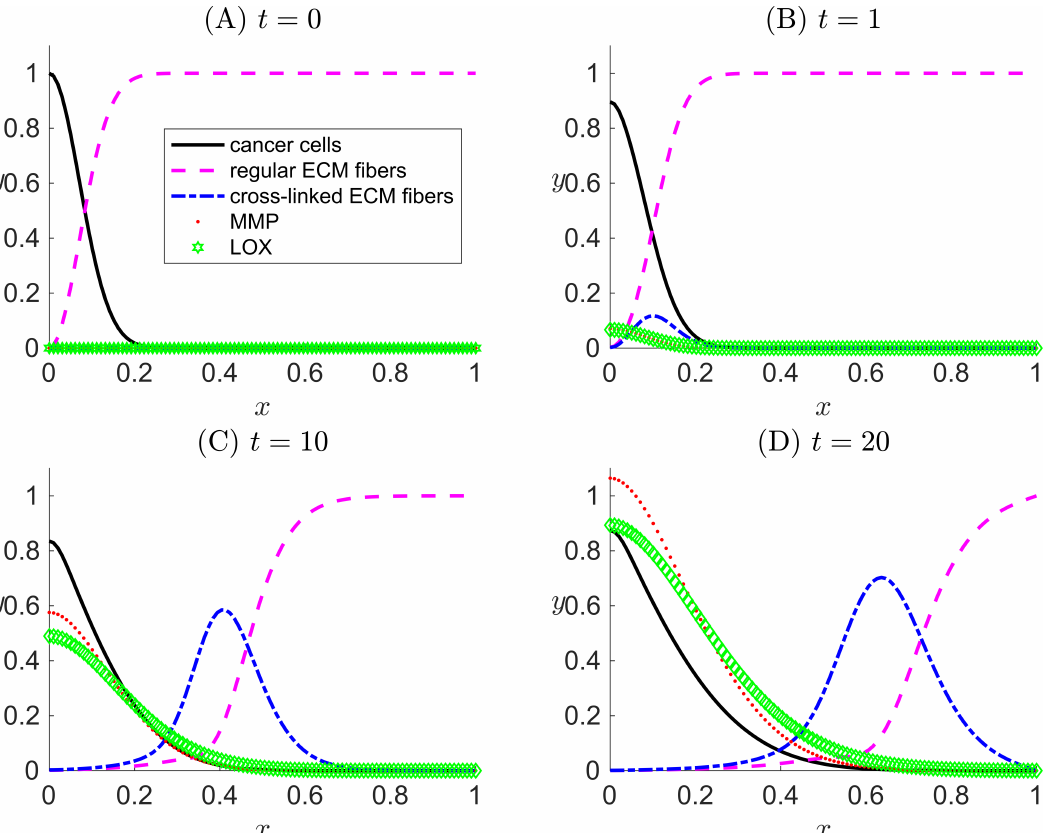
Figure 3. One-dimensional numerical results for Case II when LOX ( l (cid:54)≡ 0) and its effect only on the ECM collagen fibers and not on the cancer haptotaxis ( g ≡ 0) are considered in the modeled system. The results are snapshots of the system dynamics at four simulation times: ( A ) t = 0, ( B ) t = 1, ( C ) t = 10, and ( D ) t = 20. For all four plots, the horizontal axis x indicates the dimensionless spatial position, and the vertical axis y indicates the dimensionless population density or concentration of the species listed in the